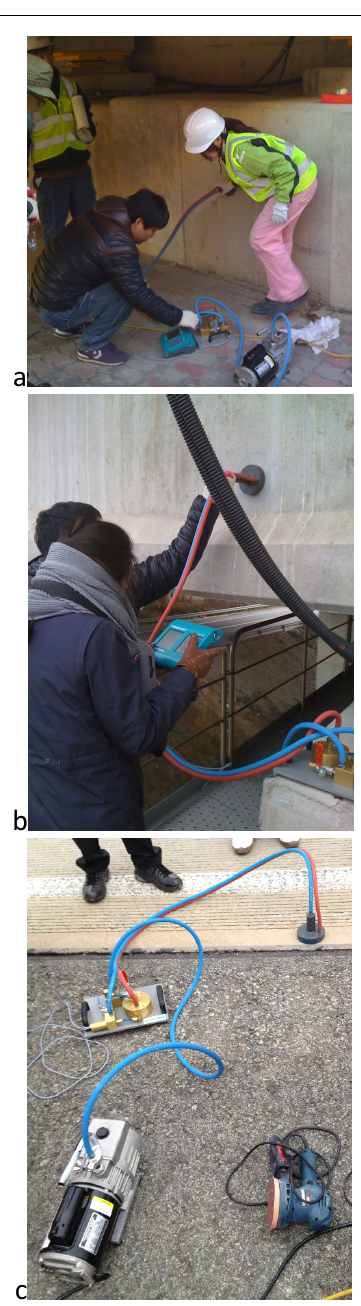
Figure 1 . Onsite air permeability measurement using the double ‐ chamber method [7] In this study, a straight circular tube was used to represent a capillary pore for theoretically investigating the relationship between the diffusion and air permeability coefficients. Then, data were collected from studies in which both the diffusion and permeability coefficients of concrete, mortar, and paste were measured, and the reported and calculated values were compared to confirm that the obtained relationship is applicable to actual cementitious materials with a complex pore